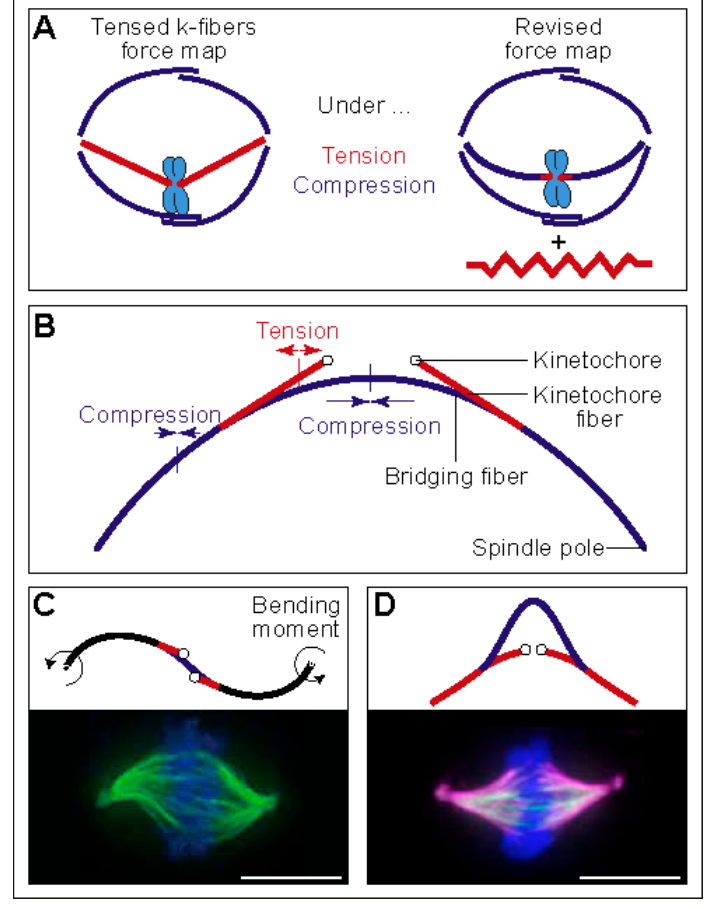
Figure 3. Linear and rotational forces that shape the spindle. ( A ) A classic force map of the spindle, in which kinetochore fibers are under tension and overlap microtubules under compression (left), and a revised force map, where tension and compression coexist along the kinetochore fiber (right). The red element next to the spindle represents a possible non-microtubule component under tension. The image is reproduced with permission from [25]. ( B ) Force balance based on a theoretical model that includes a bridging fiber as a link between sister kinetochore fibers. The compression in the bridging fiber balances the tension on kinetochores and the compression at the spindle pole. Thus, the bridging fiber allows coexistence of tension and compression (red and blue segments, respectively) within an individual kinetochore fiber. The image is reproduced with permission from [26]. ( C ) Top: Predicted shape of a microtubule bundle, resembling the letter “S”, calculated here by using the model from [26] with the parameters: L = 11.5 µ m, x j = 4.3 µ m, d k = 1 µ m, θ 0 = 64 ◦ , n k = 17, n b = 14, κ 0 = 30 pN · µ m 2 , F k = 280 pN, M 0 = 403 pN · µ m, and force at the pole in the y -direction, F 0 = 83 pN. Bending is present in the black segments. Bottom: S-shaped spindle in a lung cancer cell line. Microtubules are shown in green and DNA in blue. The image is reproduced with permission from [33]. ( D ) Predicted shape of a microtubule bundle that looks like a curved letter “A”, calculated here by using the model from [26] with parameters: L = 11.1 µ m, x j = 2.7 µ m, d k = 1 µ m, n k = 17, n b = 8, κ 0 = 30 pN · µ m 2 , F 0 = − 58 pN , F k = 280 pN, M 0 = 0. Bottom: A-shaped spindle in a HeLa cell overexpressing HSET (kinesin-14). Microtubules are shown in magenta, HSET in green, and DNA in blue. The image is reproduced with permission from [34]. Scale bars, 10 µ m.